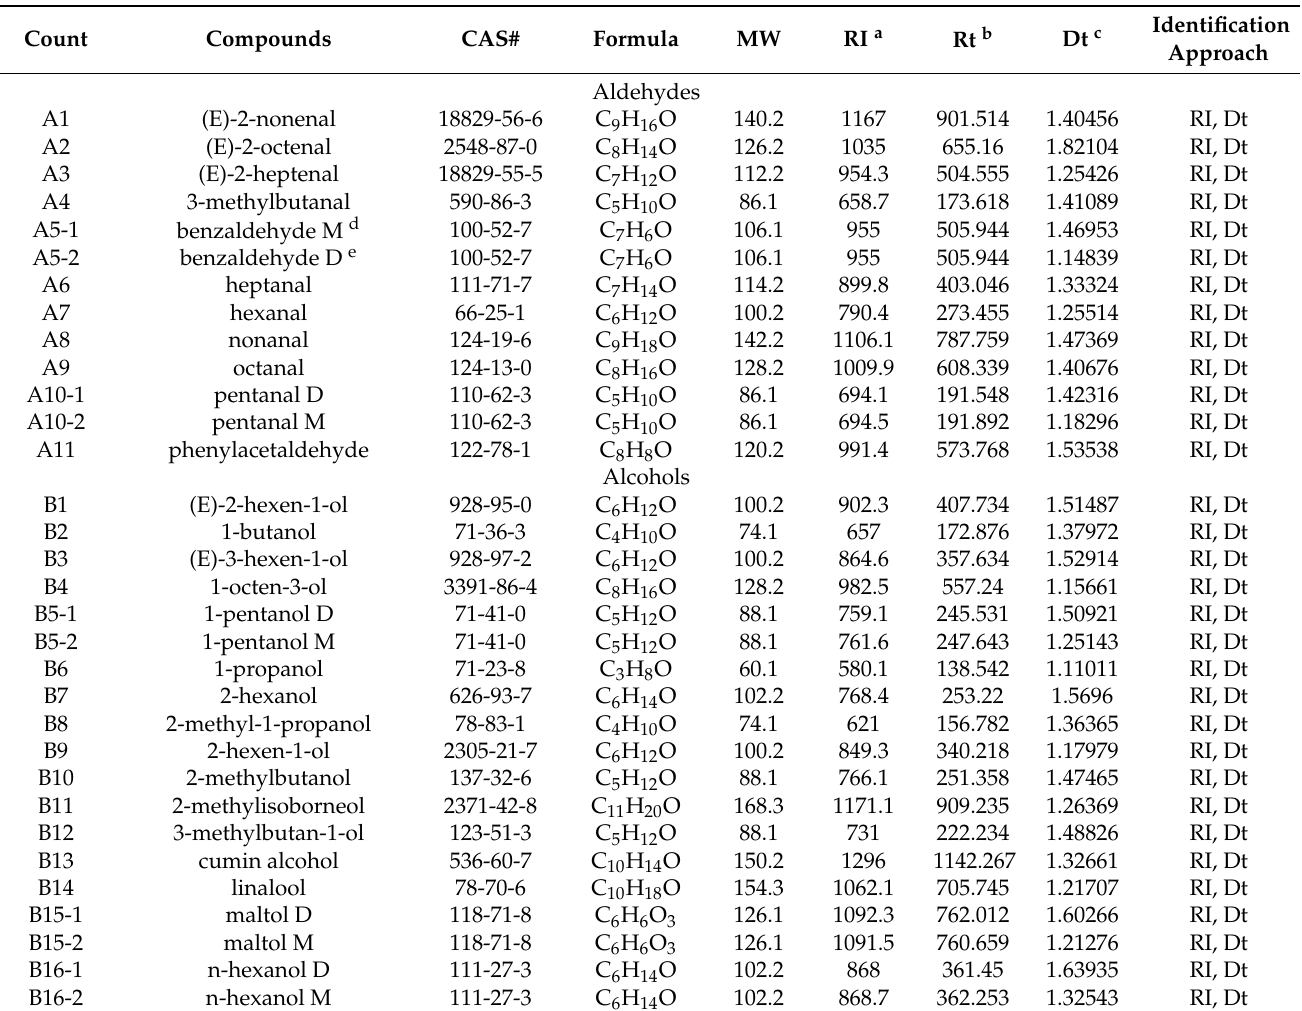
Table 1. Volatile compounds identified in three maturation stages of different green plums using